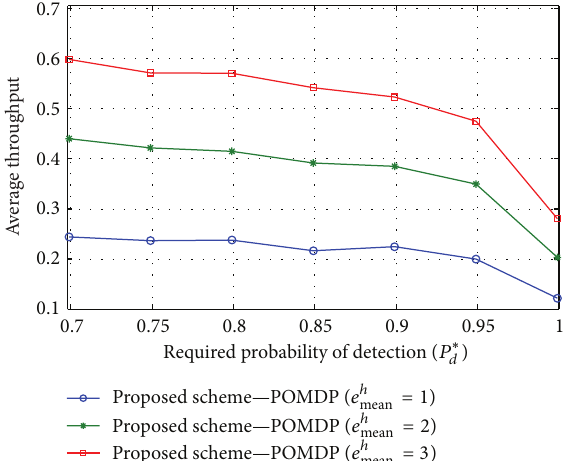
when the ca = 7 , mean